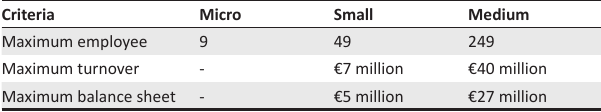
TABLE 4: European Union’s definition of small enterprises.